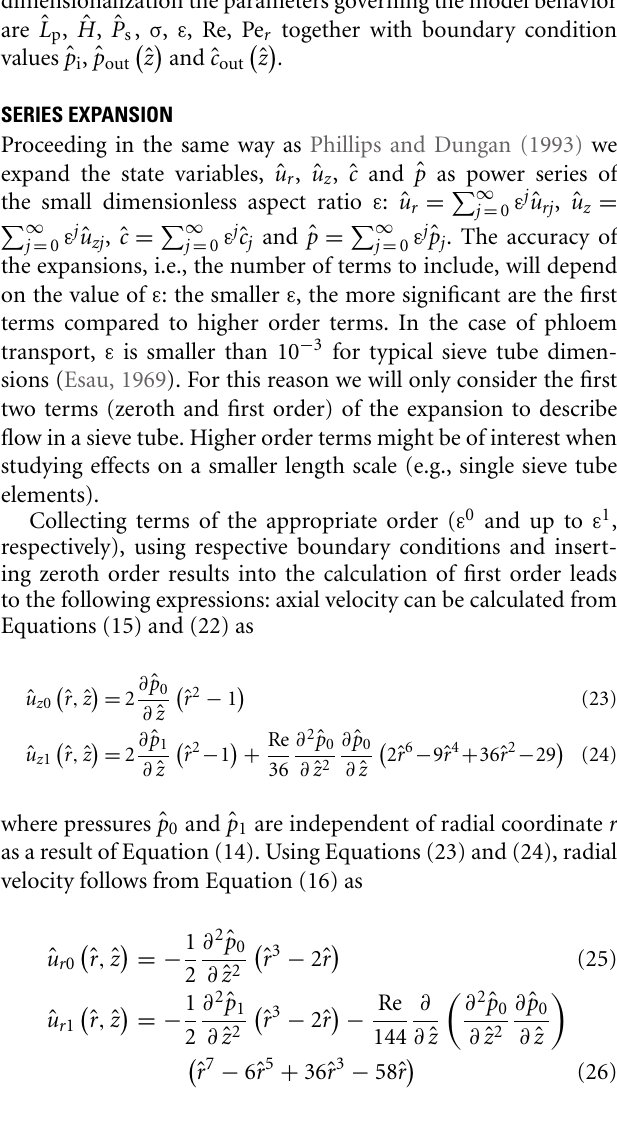
(cid:2) (cid:3) ˆ z